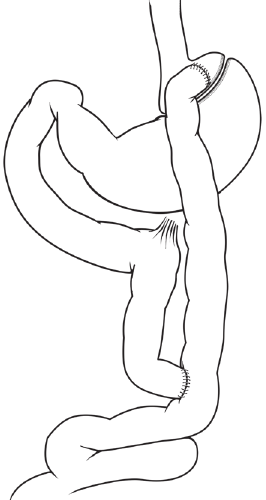
Figure 3. Roux-en-Y gastric bypass. The stomach is divided, creating a small gastric pouch that is connected through a gastro- jejunostomy to a distal segment of jejunum, which forms the Roux limb of the procedure. The remainder of the stomach is referred to as the “gastric remnant” and drains into the bypassed portion of bowel, referred to as the “biliopancreatic limb”. Bowel continuity is restored for the biliopancreatic limb by a jejuno-jejunostomy that creates the “Y” configuration of the operation. Thus, ingested nutrients proceed rapidly through the stomach pouch and move immediately into the jejunal Roux limb in the absence of bile and pancreatic secretions. Bile and pancreatic secretions drain via the biliopancreatic limb and then mix with the chyme/nutrients at the point of the jejuno-jejunostomy.